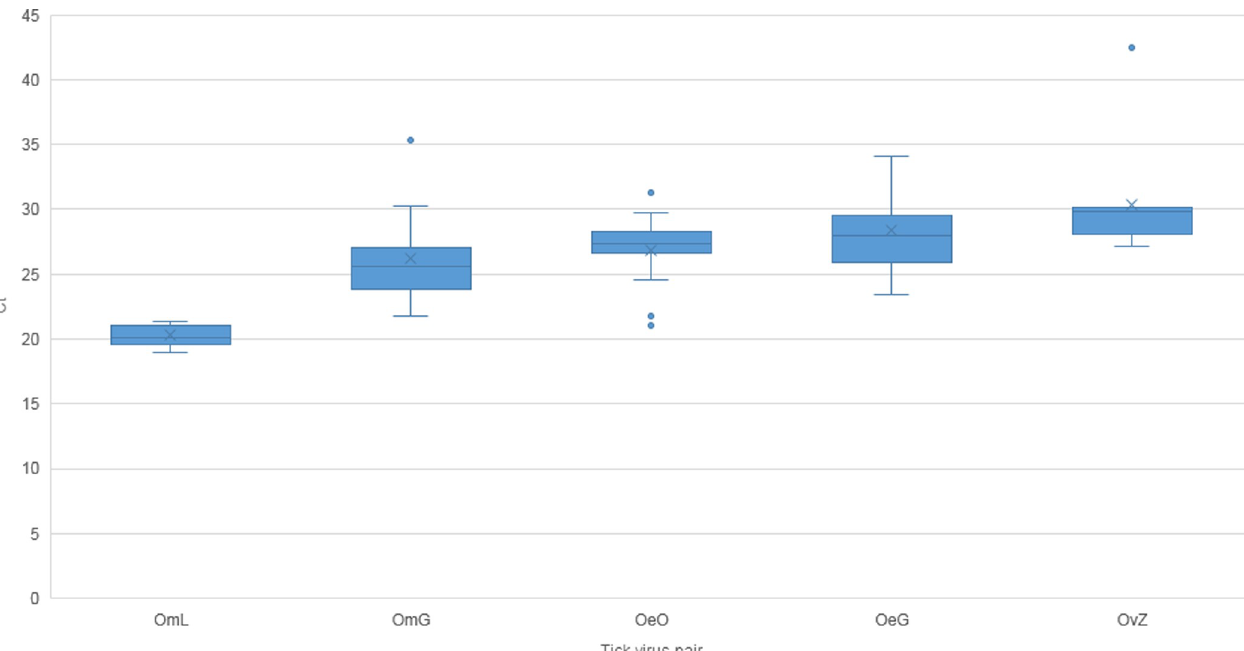
Fig 2. Detection of ASFV VP72 gene in soft ticks by real time PCR. ASFV infection was tested in soft ticks for the following viral strain associations: O . moubata -Liv13/33 (OmL), O . moubata -Georgia2007/1 (OmG), O . erraticus -OurT88/1 (OeO), O . erraticus -Georgia2007/1 (OeG) and O . verrucosus -Urk12/ Zapo (OvZ). Ct = Cycle Threshold.